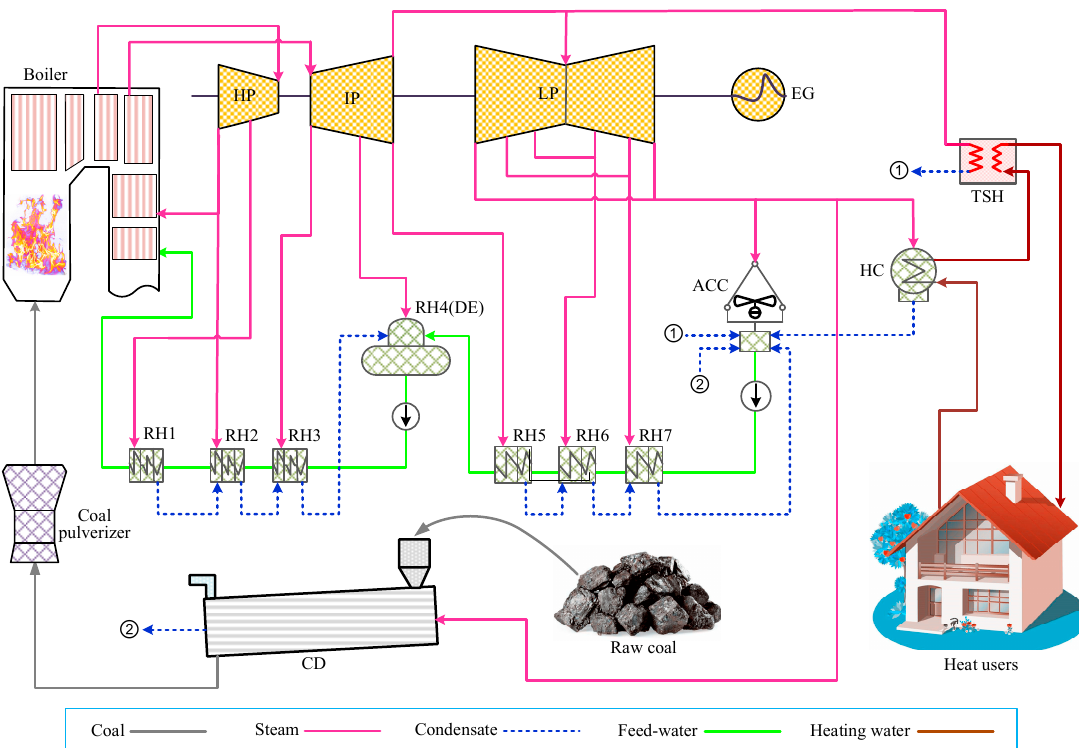
Figure 2. Diagram of the modified HBP heating system integrated with raw coal pre-drying (based on the reference HBP-CHP unit).